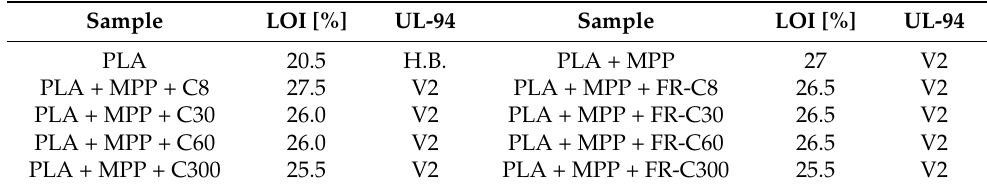
Table 8. LOI and UL-94 test results of the composite samples with differing cellulose fibre